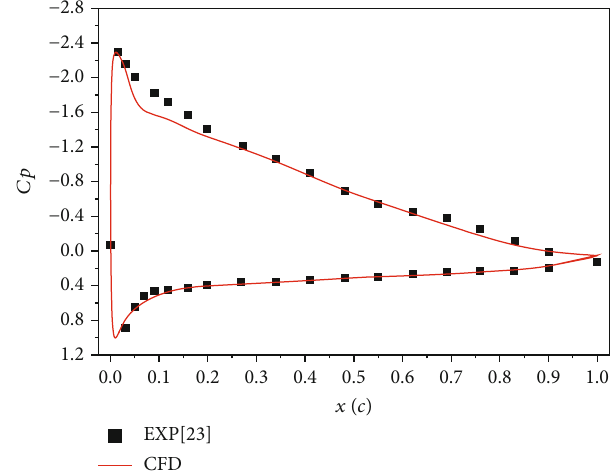
Figure 7: Comparison of pressure coe ffi cient for ground e ff ect